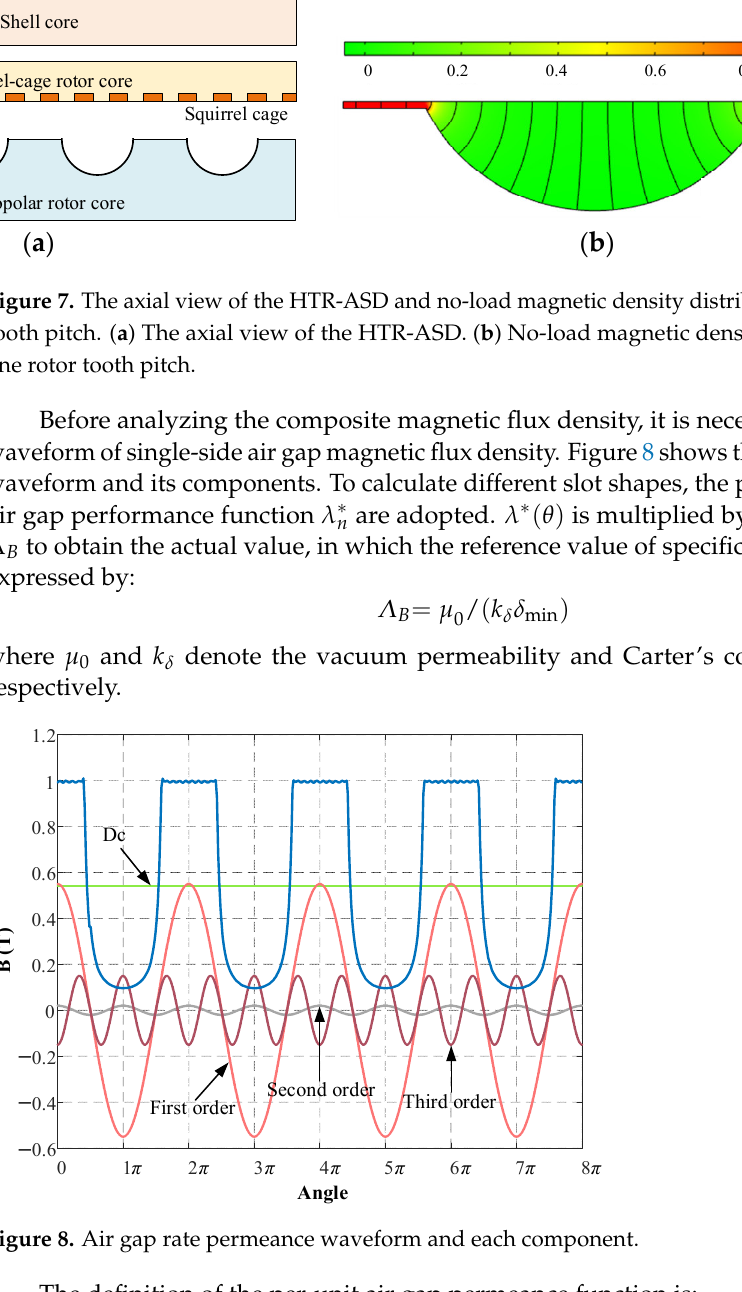
Figure 8. Air gap rate permeance waveform and each component.